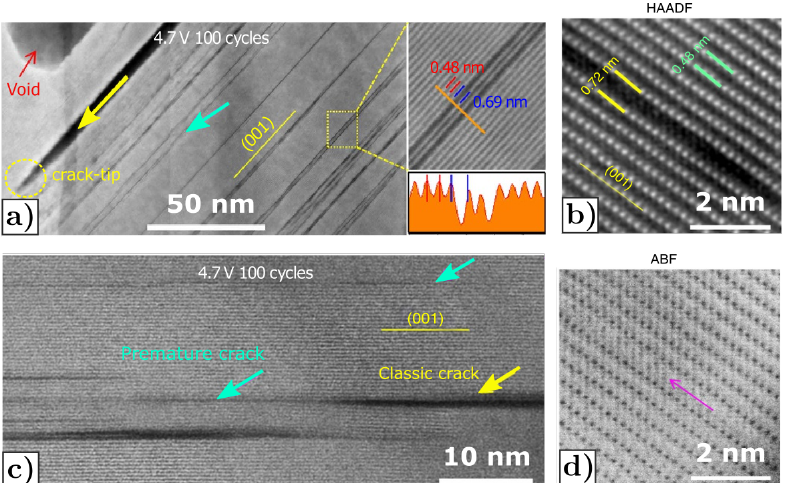
Figure 21. ( a , c ) HAADF images from cycled NMC333 cathode particle showing intragranular cracks along the (001) plane. The yellow and light blue arrows indicate classic and premature cracks, respectively. ( b ) HAADF and ( d ) ABF images along [010] axis of the premature crack showed in ( a ). Reprinted with permission from Springer Nature by [108], Copyright